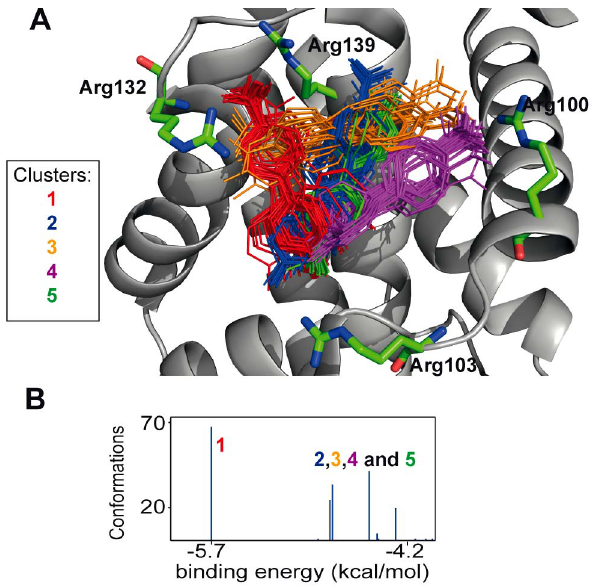
Figure 4. Docked positions of fragment 1 on the protein Bcl-xL binding surface. (A) Superposition of 200 structures of fragment 1 docked into the Bcl-xL binding site. Five clusters are observed (72 poses in red, 37 in blue, 24 in green, 24 in orange and 43 in magenta). (B) Energy binding (in kcal/mol) histogram for the 5 clusters.